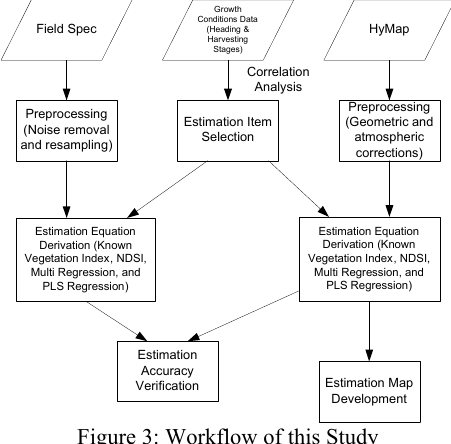
Figure 3: Workflow of this